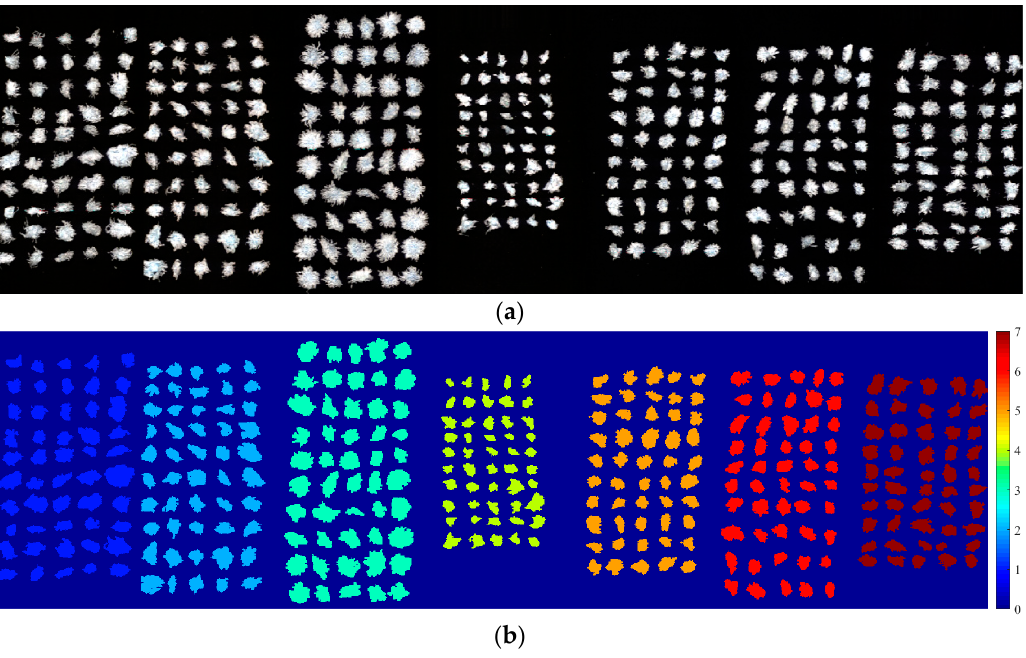
Figure 4. Visualization of Chrysanthemum varieties (from left to right: Boju, Chuju, Gongju, Hangbaiju, white Huaiju, yellow Huaiju, and Qiju): ( a ) Original grayscale images; ( b ) The classification maps.